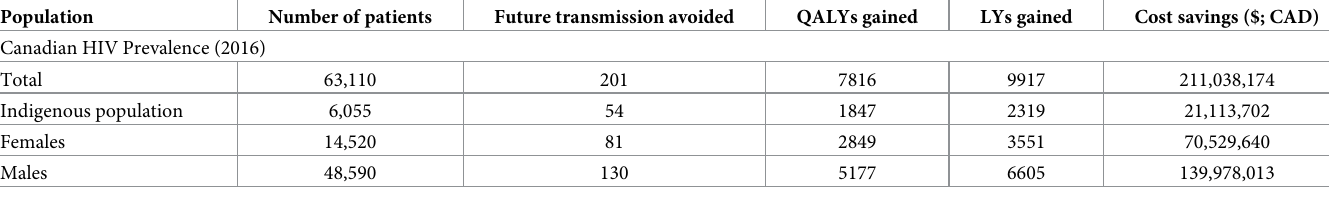
Table 5. Benefits of LA DOT extrapolated to the HIV-infected population of Canada. Population Number of